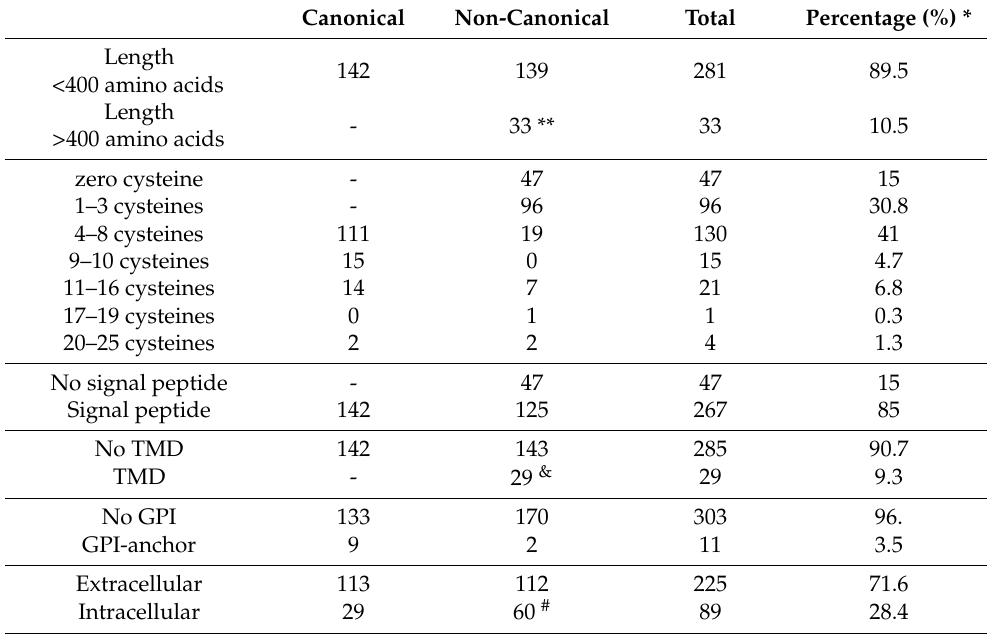
Table 2. Summary of in silico characterization of canonical and non-canonical fungal/oomycete true